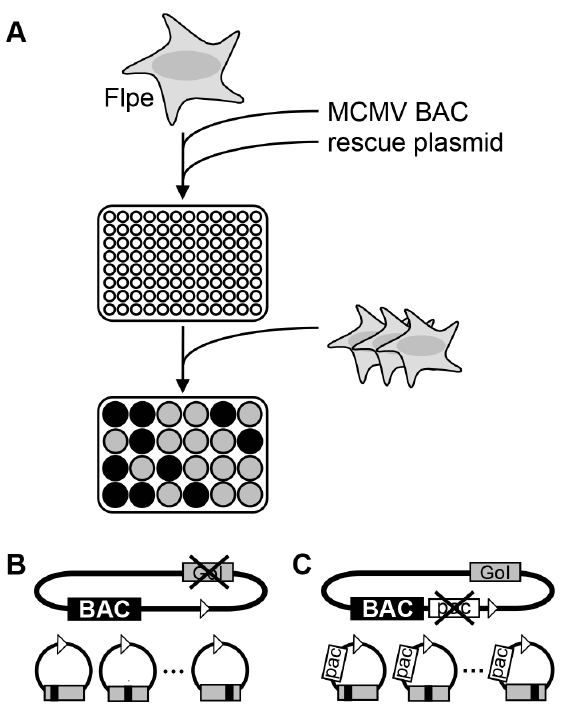
Figure 1. Principle of the cell-based screening system. (A) Murine fibroblasts stably expressing enhanced eukaryotic Flp recombi- nase (Flpe) were mixed with BAC DNA, which lacks an essential feature and carries an FRT site for homologous recombination, and a shuttle plasmid, which carries a second FRT site, and transfected by nucleofection. Transfected cells were mixed with non-modified fibroblasts at a ratio of 1:3, seeded on multi-well plates and viral plaque formation was monitored. The unification of the shuttle plasmid and the target genome takes place within the host cell in the presence of Flpe expression. (B) Cell-based complementation assay (CCA). The MCMV target BAC is deficient for an essential viral gene (GoI, gray box), which is mutated and subcloned into the rescue plasmid (gray box with black line). Viral reconstitution (formation of plaques) was expected if the mutated gene was able to complement the wt protein function